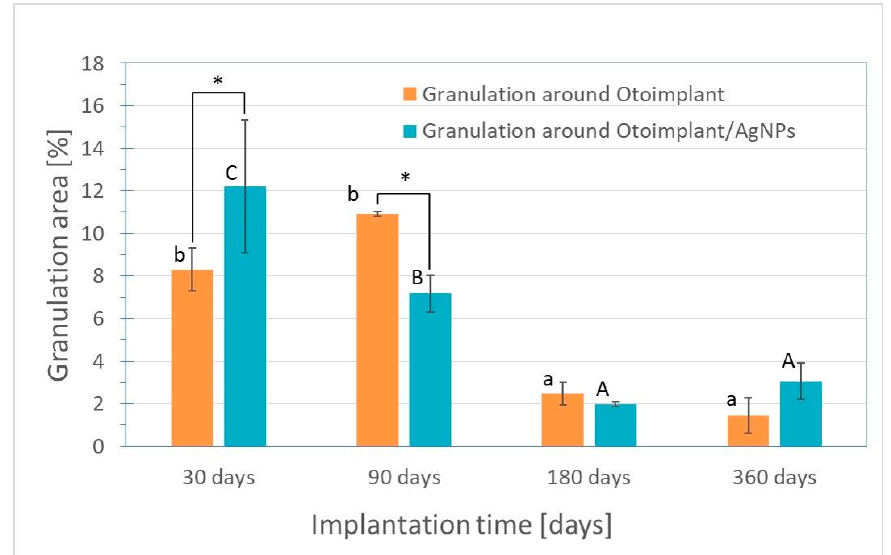
Figure 8. Granulation area for otoimplant and otoimplant/AgNPs measured after 30, 90,180 and 360 days of the implantation. Statistically significant differences ( p < 0.05) between otoimplant and otoimplant/AgNPs after specific implantation time are indicated by *; between different implantation times for otoimplant and otoimplant/AgNPs—by a–b and A–C, respectively.